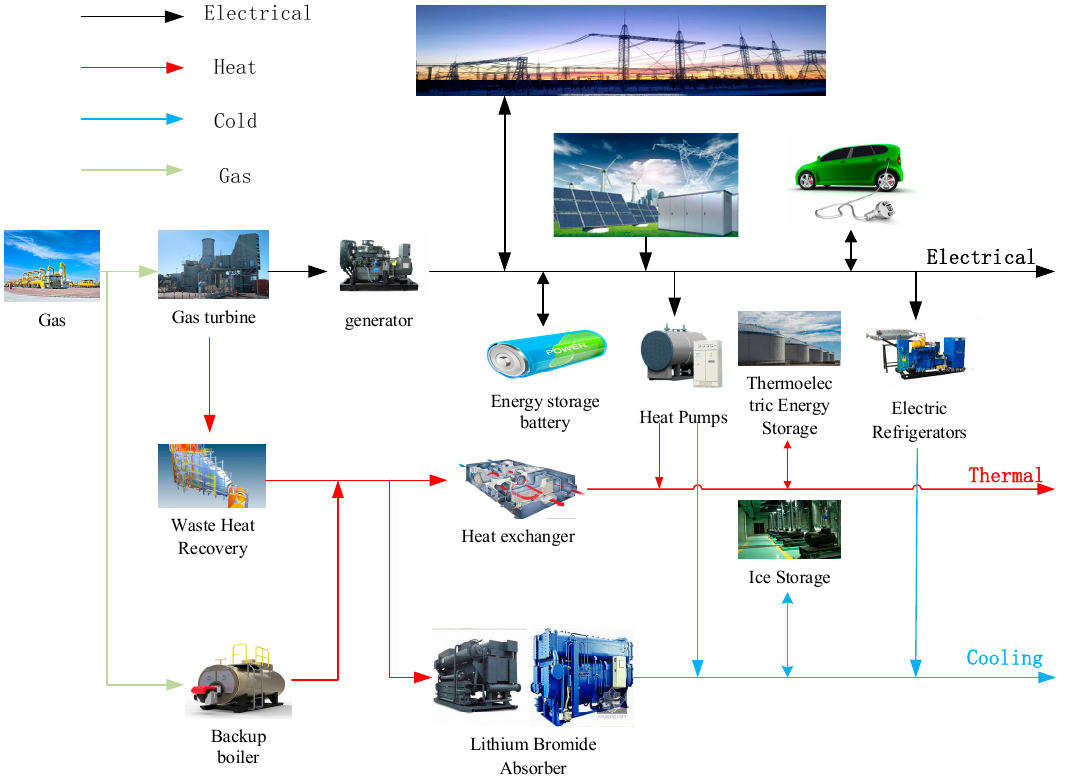
Figure 1. Physical model of integrated energy system considering integrated demand response (IDR).